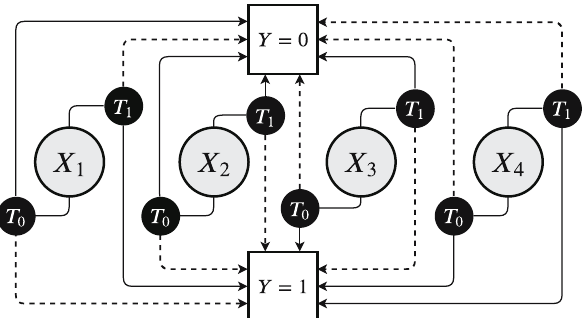
Figure 2: Finite MDP for a CMAB in CATE optimisation. Grey circles denote individuals of type X j X ⊂ ; squares indicate the response Y 1 = or Y 0 = ; black circles represent treatments with T 0 if T 0 = and T 1 if T 1 = , done so for brevity; dashed arrows are used when Y T X ,